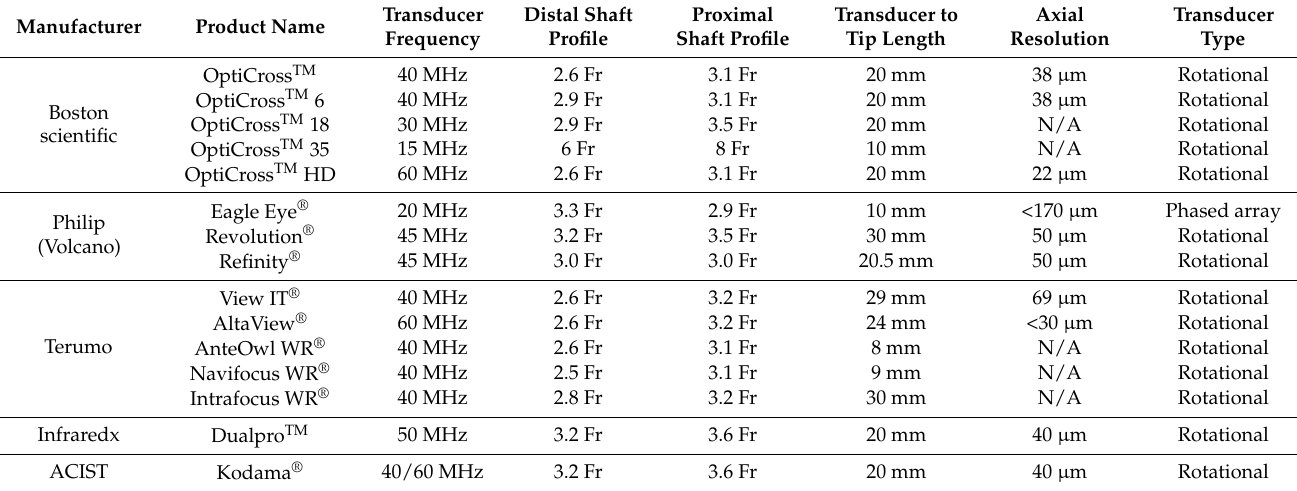
Table 2. The existing available commercial IVUS